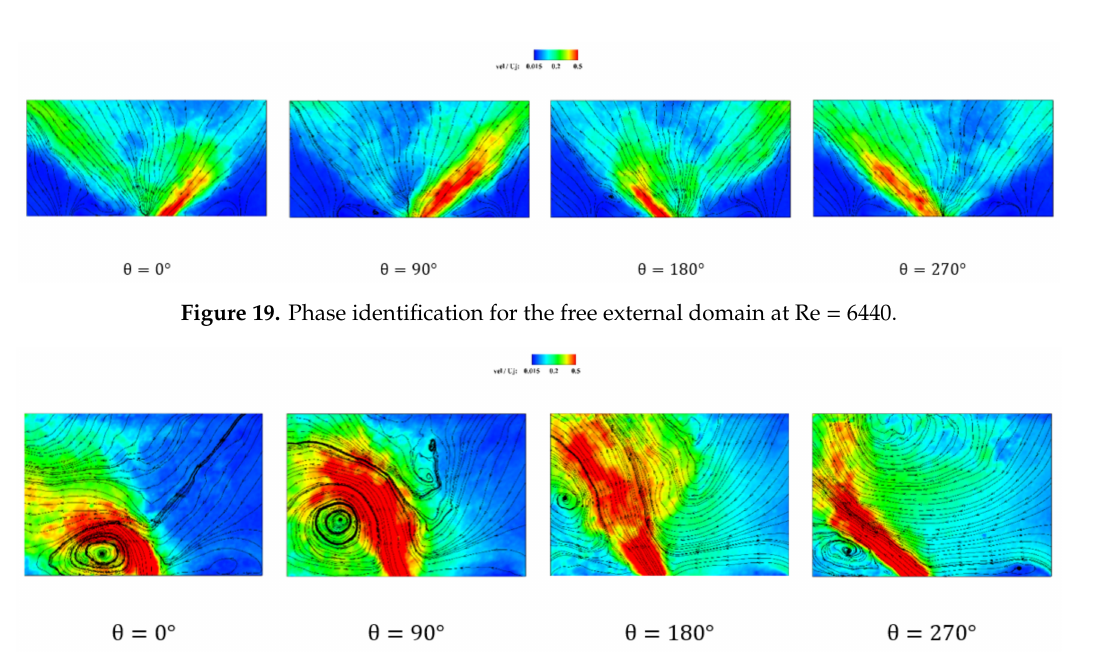
Figure 20. Phase identification for the fully confined external domain at Re =